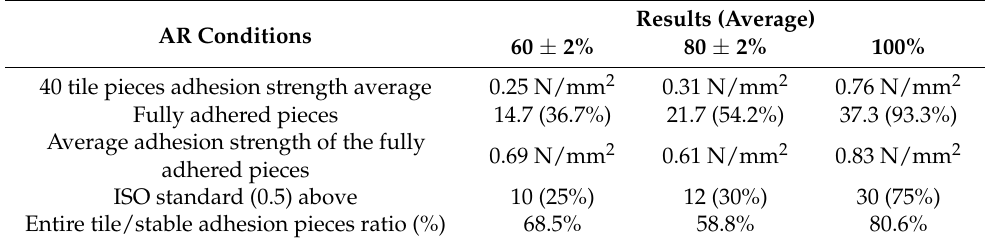
Table 11. Overall adhesion strength result per spot-bonding surface area condition.